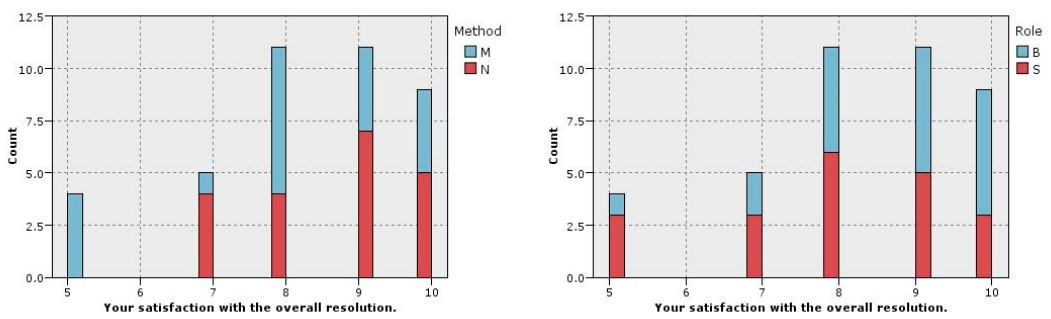
Figure 8. Satisfaction with the overall resolution (M: e-mail, N: E-NeGotiAtion, B: buyer, S: seller). The final questionnaire was also focused on the evaluation of the new E-NeGotiAtion method. Figure 9 shows expressed satisfaction with the fact that the E-Negotiation method selected the most appropriate solution(s), depending on the assigned